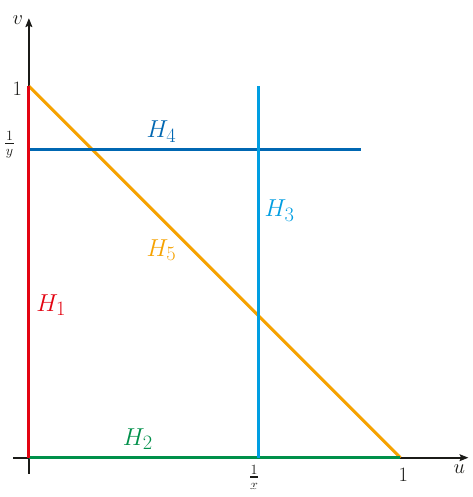
Figure 2 . Geometry for the Appell F 3 integral representation in eq.